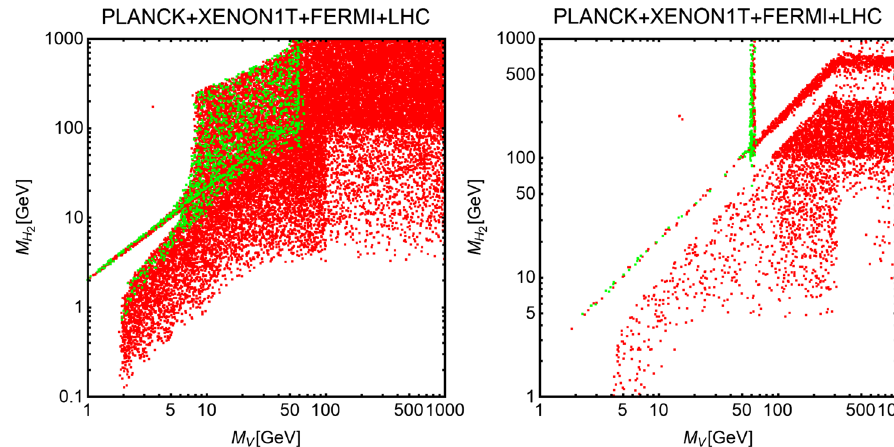
Fig. 18 The same as Fig. 11 but for the dark SU(3) model with a single component DM V 1 , 2 (left panel) and multicomponent V 1 , 2 , 3 DM (right